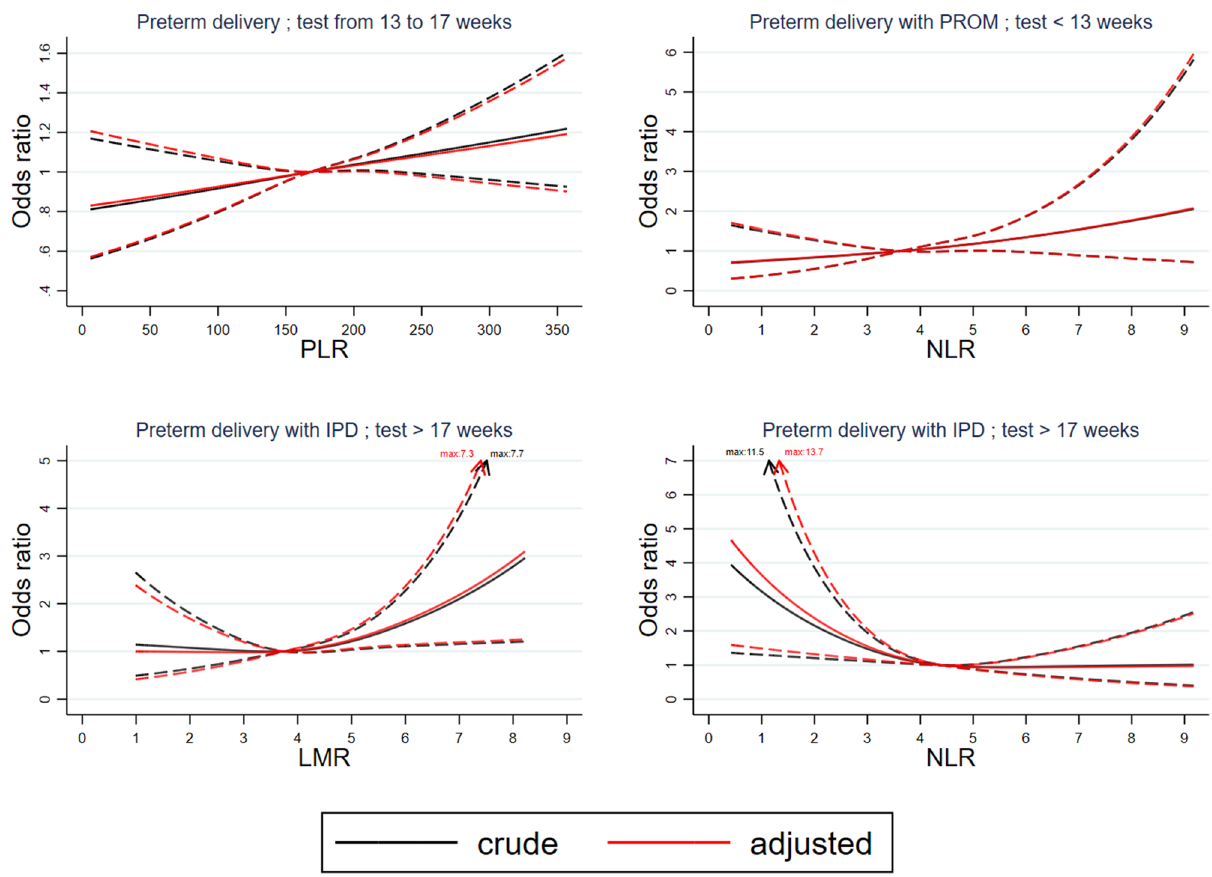
Figure 2. Risk of preterm delivery by blood count parameters. Reference is set at median of observed values of each parameter at each